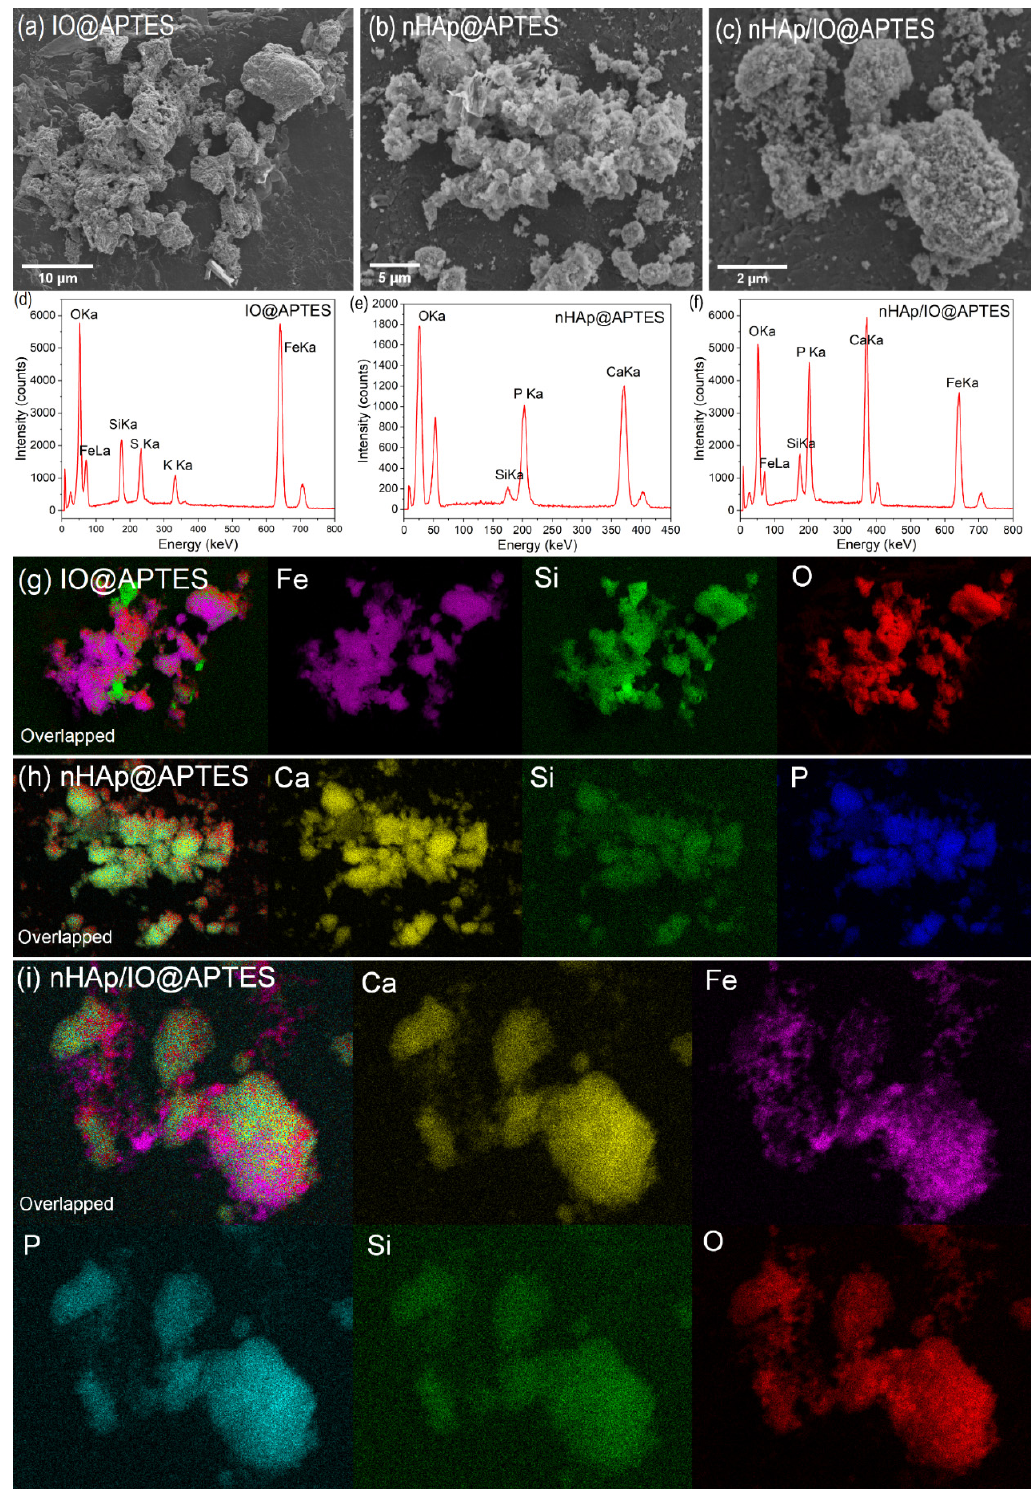
Figure 2. SEM images ( a – c ) and EDS analysis ( d – f ), as well as SEM-EDS elemental maps ( g – i )